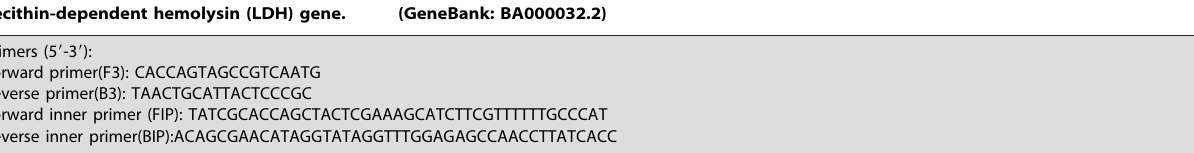
Lecithin-dependent hemolysin (LDH) gene.